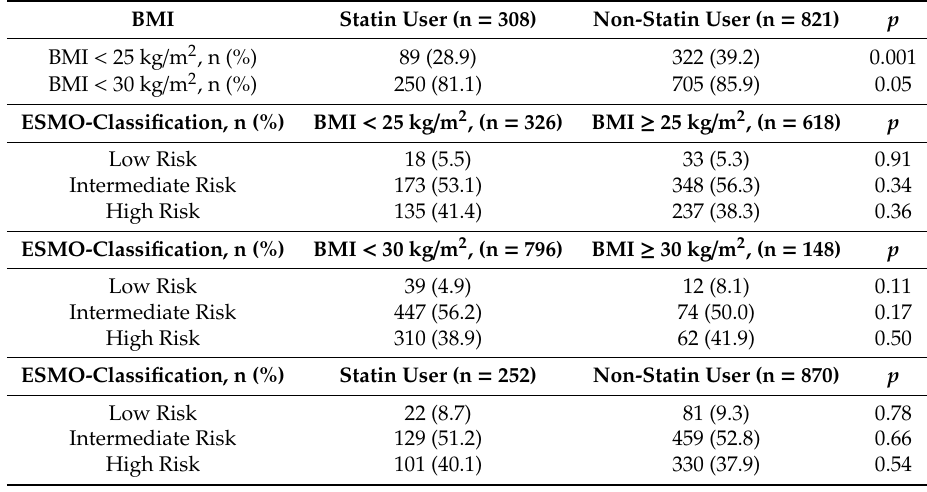
Table 2. Distribution of statin use and ESMO-classification per body mass index (BMI) group; Distribution of ESMO-classification among statin